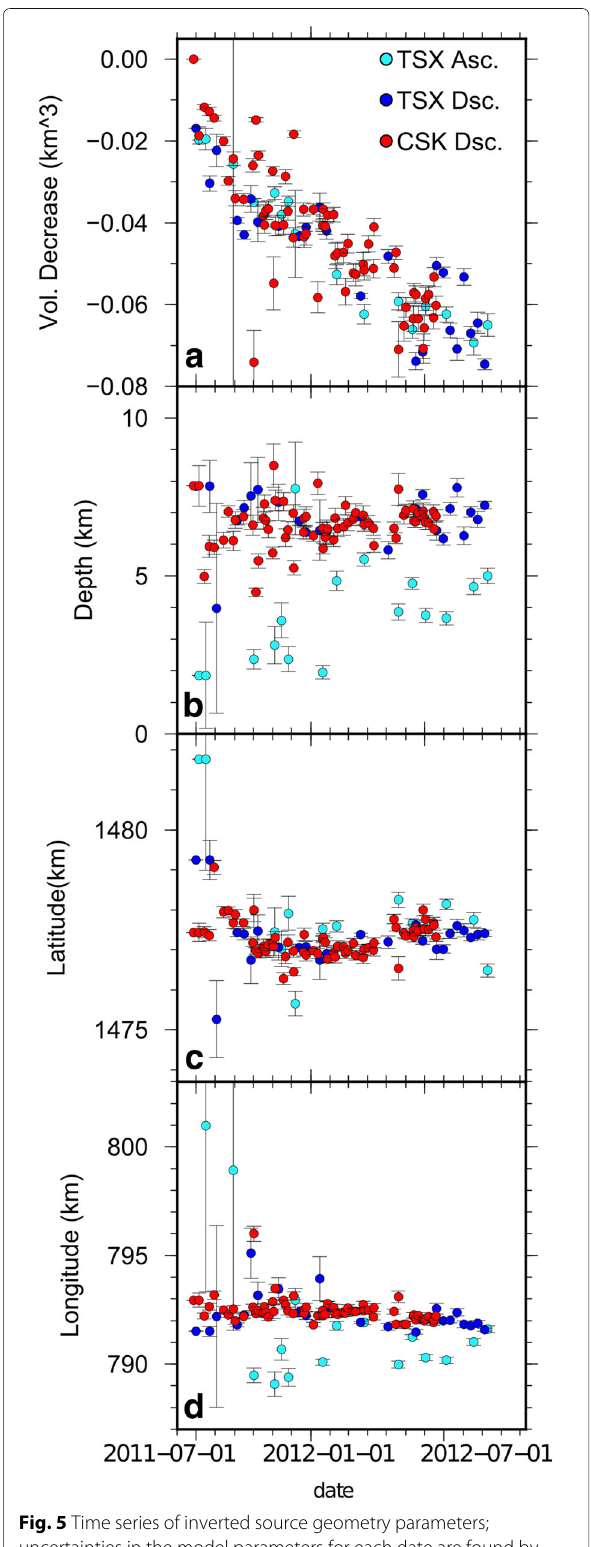
Fig. 5 Time series of inverted source geometry